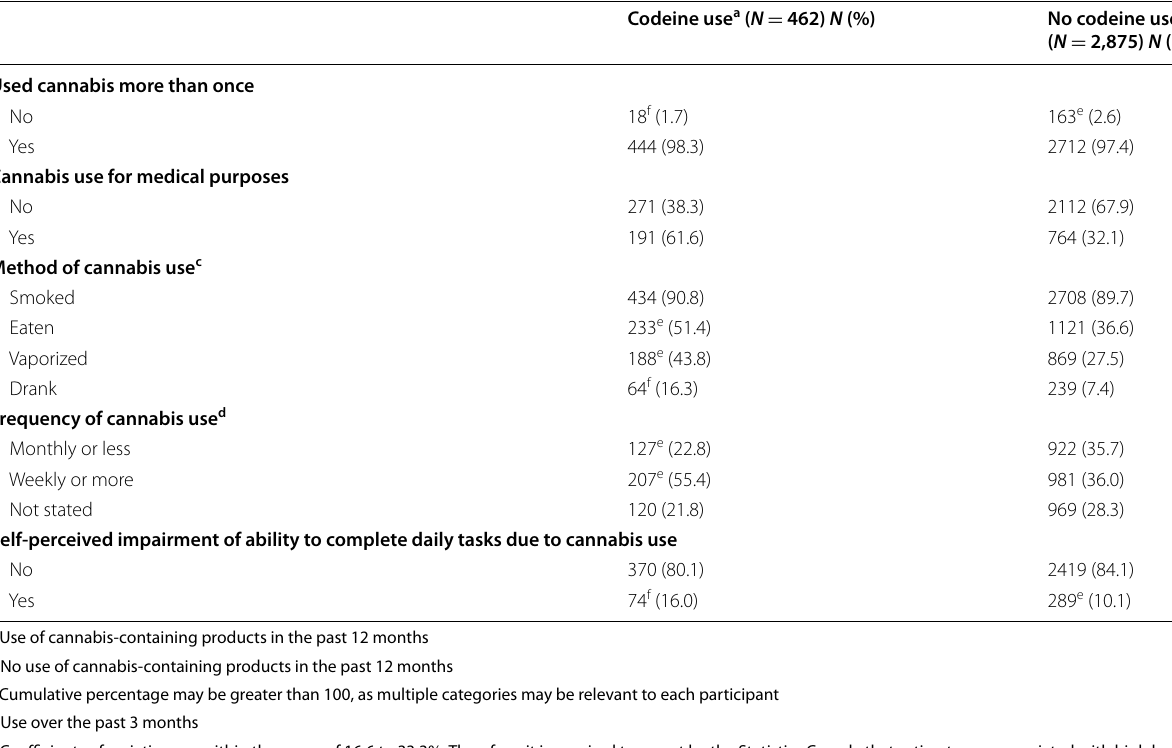
Table 2 Characteristics of cannabis use among codeine users and nonusers, Canadian Tobacco, Alcohol and Drugs Survey (2017), study sample ( N =